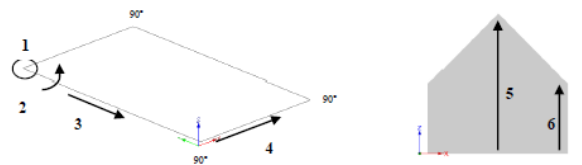
Figure 5. Step sequence for gabled roof type geometry